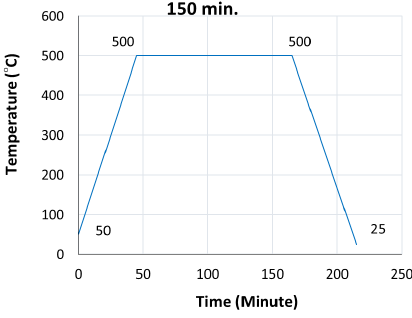
Figure 2: Sintering program